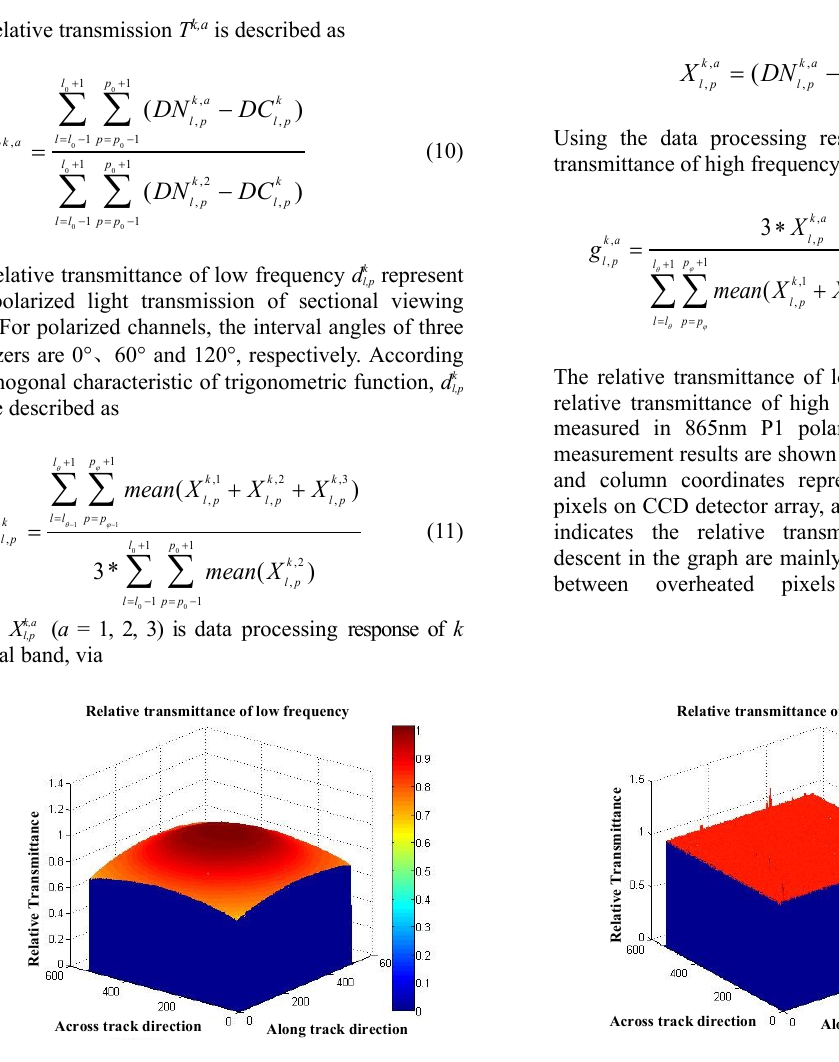
Figure 8. Measurement results of the relative transmittance of low frequency (left) and relative transmittance of high frequency in DPC 865nm P1 polarized channel